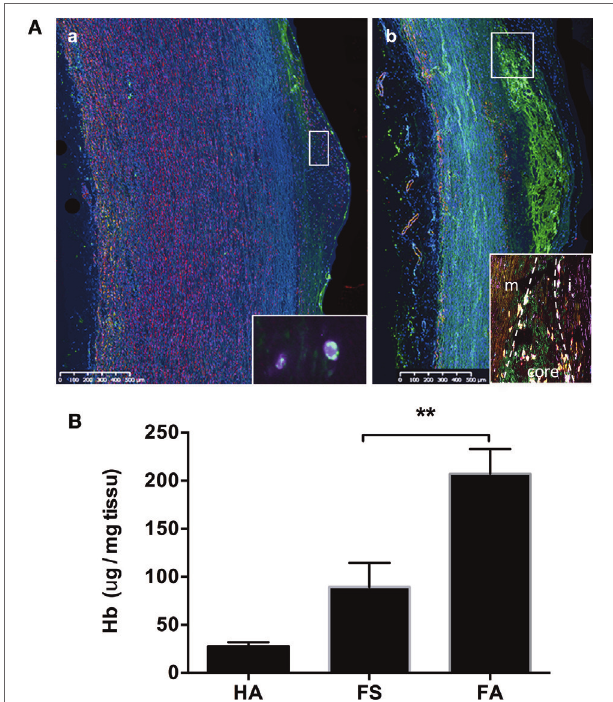
FigUre 2 | Hemoglobin deposits in fatty streaks and fibro-atheroma lesions. Detection of Hb (green) and SMC myosin (pink) [ (a) , a] in the endothelium and subendothelial space of a fatty streak [inset: high magnification ( × 100) showing the intracellular co-localization of myosin and Hb (merged yellow)], and [ (a) , b] in in the lipid core (between the fibrocellular cap and the media) of a fibroatheroma lesion [inset: high magnification of the plaque shoulder (m, media; i, intima; core shoulder) showing the presence of SMC myosin (pink) and hemoglobin (green), and their frequent localization (merged yellow)]. For negative control, there is no green autofluorescence in the lipid core (not shown). (B) Measurement of heme content in FS and FA tissue by formic acid reaction. ** p < 0.01; Mann–Whitney’s